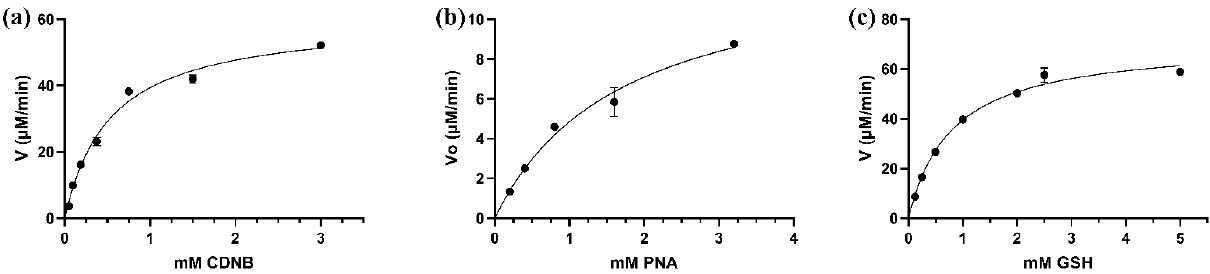
Figure 5. Steady-state initial velocities are plotted versus substrate concentrations. ( a ) CDNB 0.05 to 3 mM; ( b ) PNA concentrations were varied from 0.2 to 3.2 mM; ( c ) GSH concentrations were varied from 0.125 to 5 mM. Plots were curve fit by non-linear regression and generated with GraphPad Prism (GraphPad, San Diego, CA, USA).